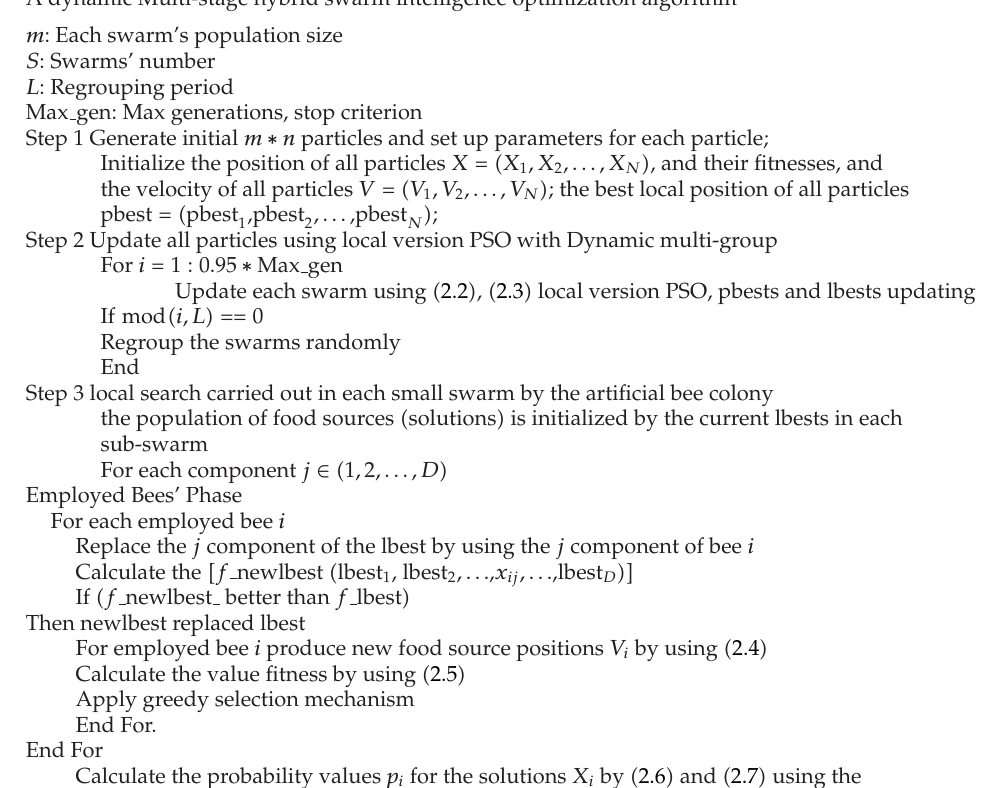
A dynamic Multi-stage hybrid swarm intelligence optimization algorithm